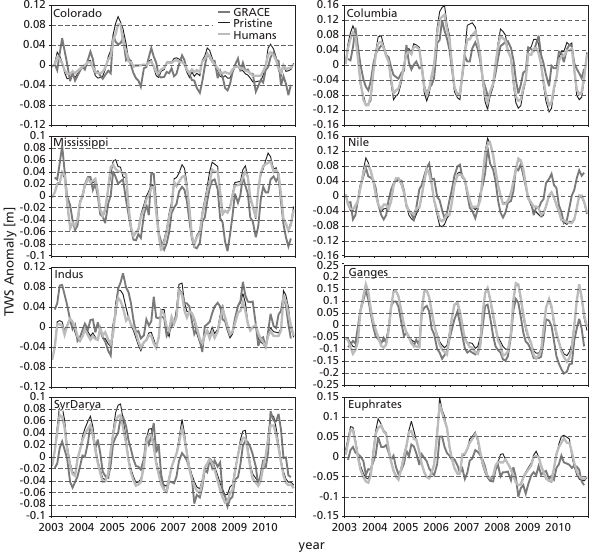
Fig. 8. Sensitivity of water allocation scheme in simulated global (a) groundwater and (b) surface water withdrawals [km 3 yr − 1 ] over the period 1979–2010 based on three scenarios. Scenario 1 corresponds to the water allocation algorithm of this study (Eq. 13). Under Sce- nario 2, water demand is first met from the groundwater storage ( S 3 ) and the remaining water demand is withdrawn from surface water (including reservoirs). Under Scenario 3, water demand is first met from surface water and the remaining water demand is withdrawn from the groundwater storage. The results were obtained from the mean of the simulation with the ERA-Interim and MERRA